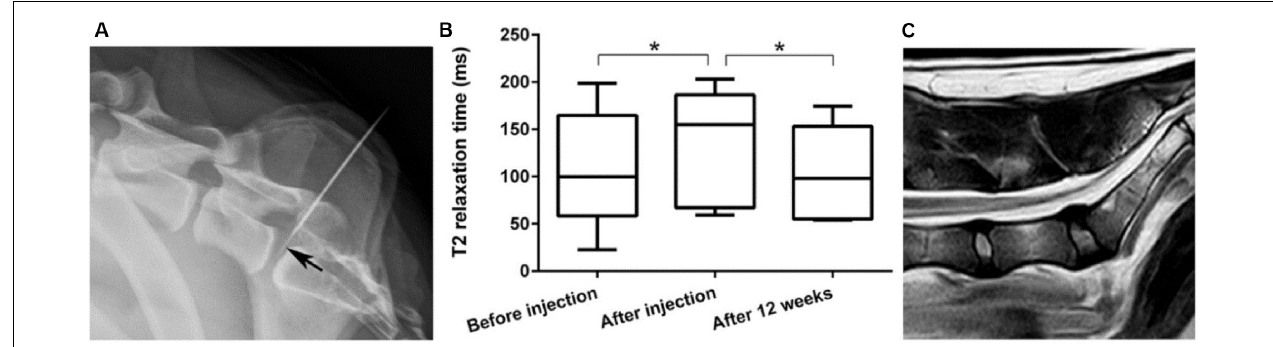
FIGURE 6 | (A) Laterolateral radiographic images of fluoroscopy-guided intradiscal injection. Note that the 20-G needle advanced into the epidural space and the 27-G needle (arrow) positioned in the center of the NP. (B) T2 mapping values of the NP were significantly higher after injection compared with those at preinjection and 3 months’ follow-up. (C) Representative T2 magnetic resonance image 3 months after intradiscal injection with the celecoxib-loaded hydrogel. Reproduced from Tellegen et al. (2018) with permission from Copyright 2018 Wiley. * p <